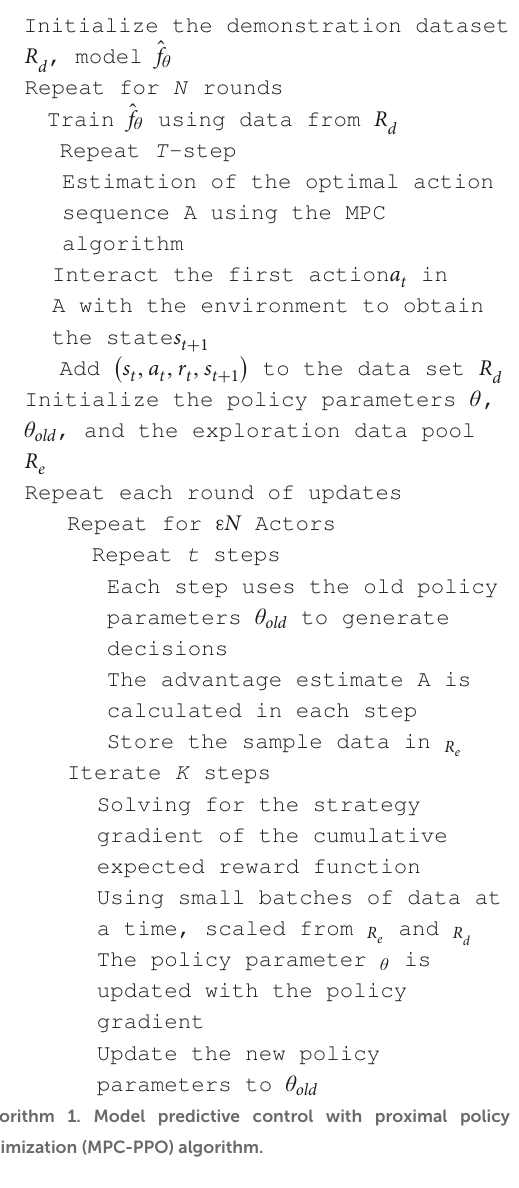
Algorithm 1. Model predictive control with proximal policy optimization (MPC-PPO)